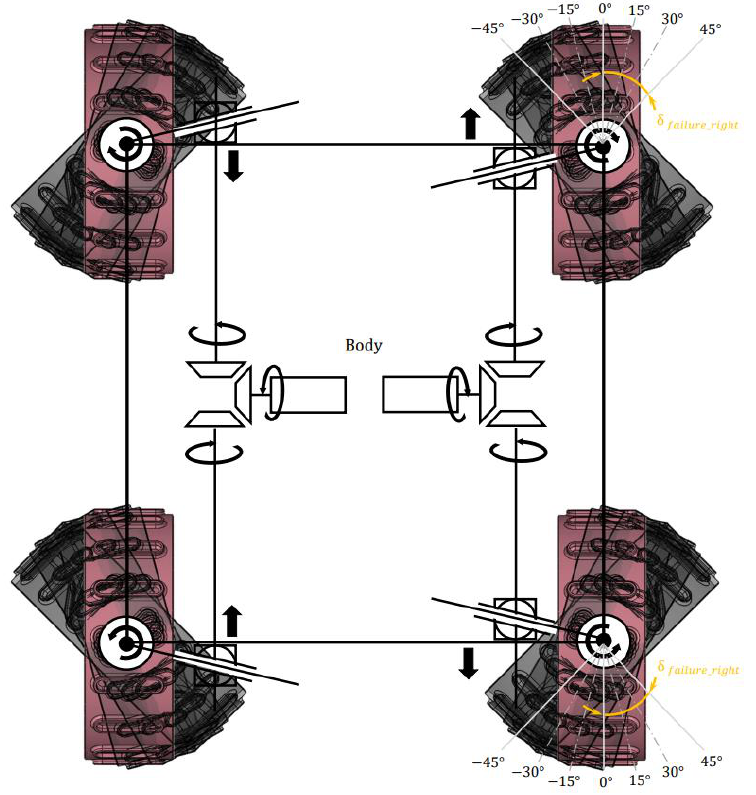
Figure 15. Failure case categorization of the seven discrete angle ranges in the rover ’ s right steering motor failure.